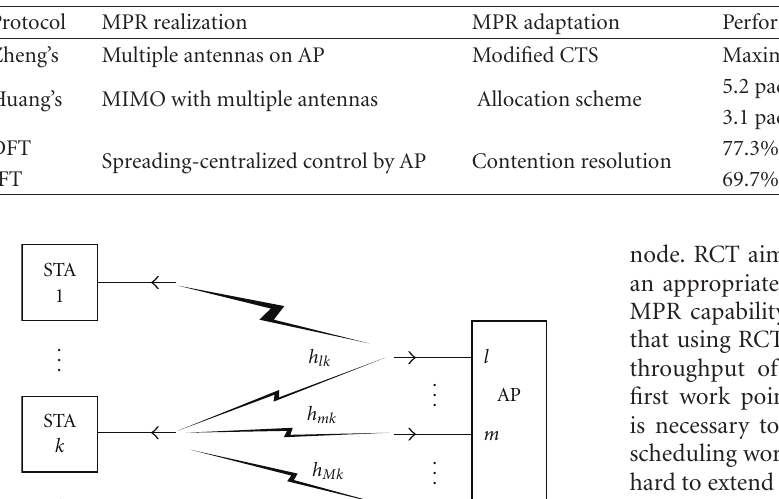
Figure 3: Classification of techniques applied for MPR. Table 2: WLAN with MPR.